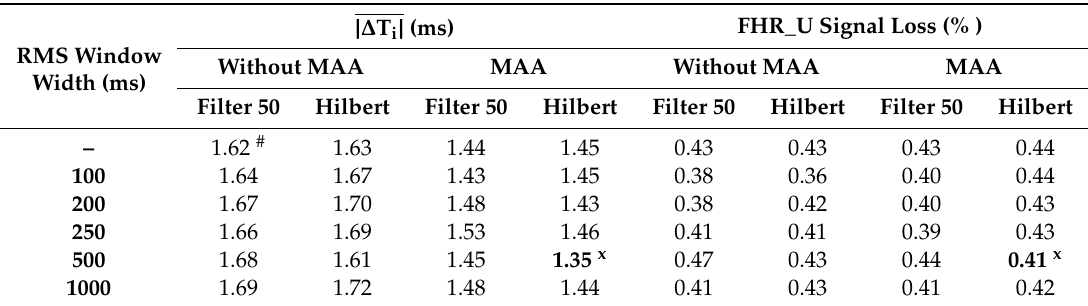
Table 4. Interval measurements errors and the FHR_U signal loss for di ff erent starting points, with and without additional matching algorithm